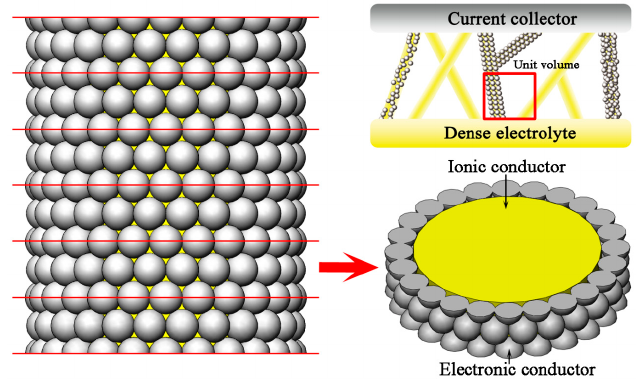
Figure 3. The schematic diagram of the repeating unit.